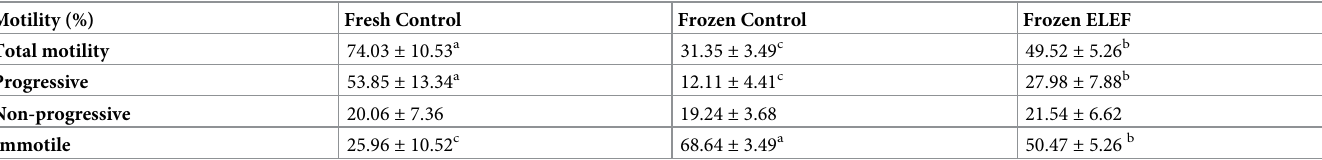
Table 1. Effects of freezing medium prepare from treated and untreated waters on sperm motility. The assigned letters of a, b and c indicate significant differences (p < 0.05) among the groups. Values are expressed as mean ± SD, Tukey test; n = 25. P-value adjustment for multiple comparisons: Bonferroni. Motility